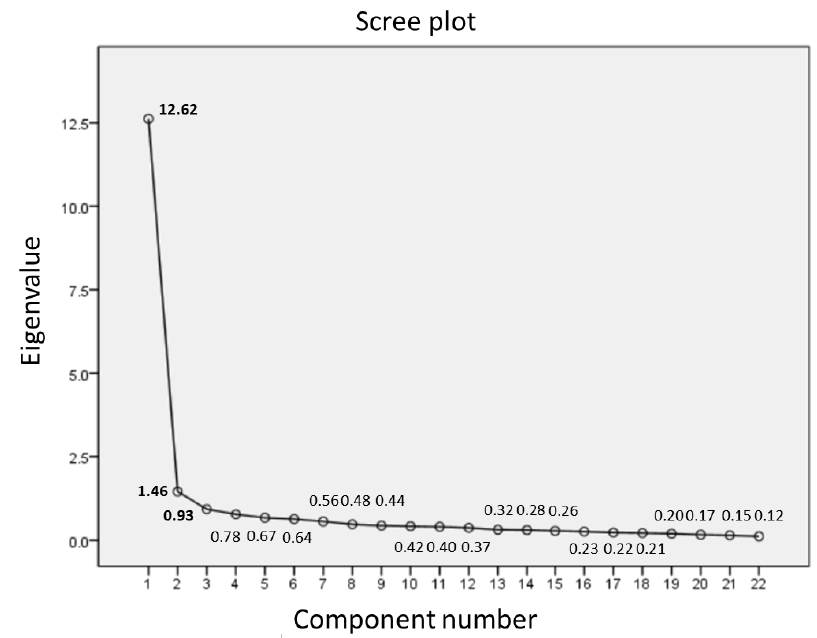
Figure 1. Scree plot of the eigenvalues .